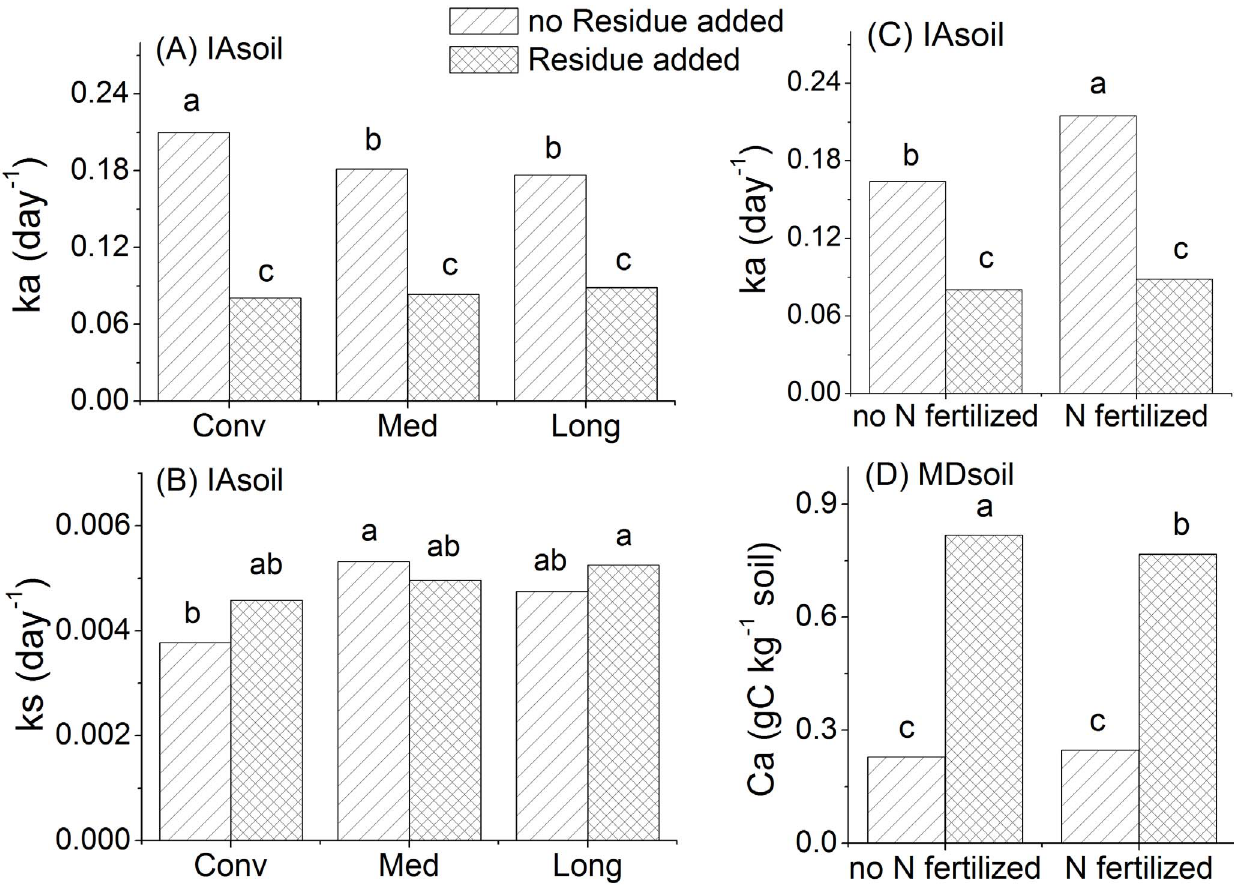
Figure 4. Interactions between residue addition and cropping system or N fertilization on C mineralization coefficients. Different letters above bars indicate statistically significant difference at p , 0.05, comparisons were made within each sub-figure.